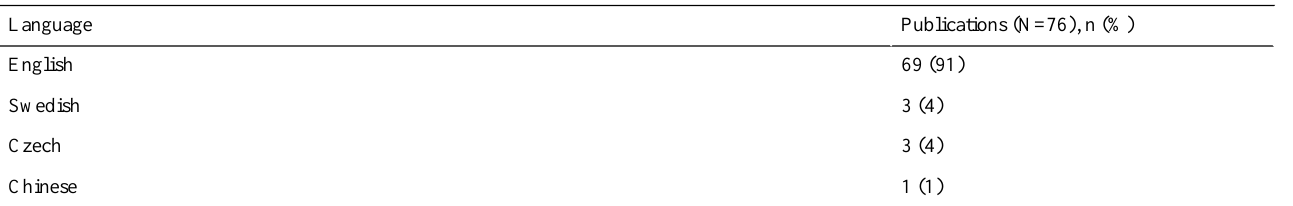
Table 3. Target language in